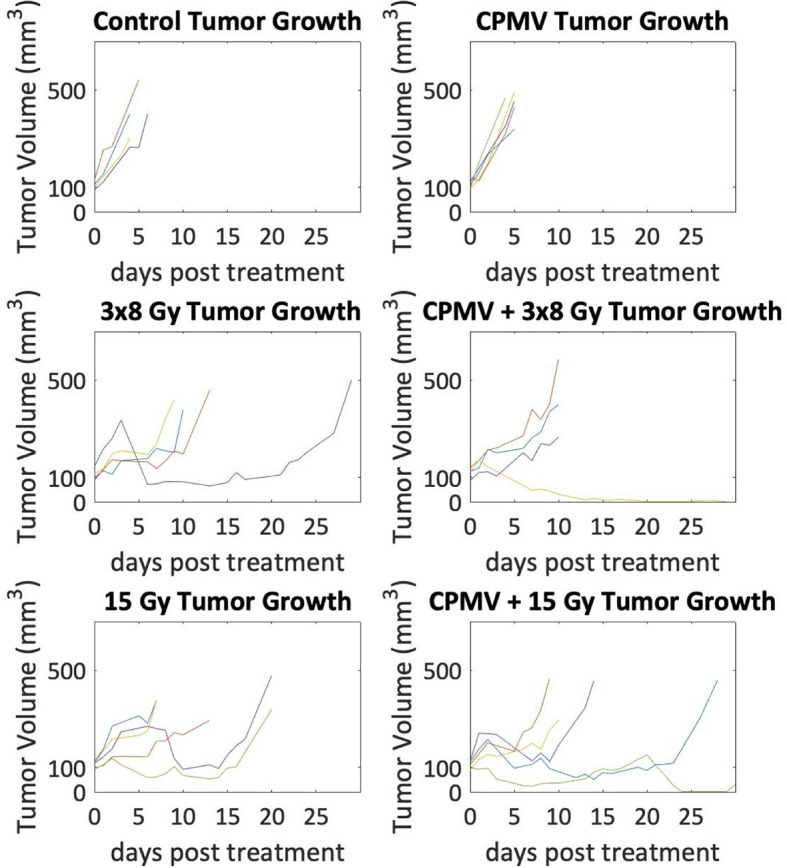
Tumor Growth Curves. Tumor growth curves for each animal with tumor volume on a logarithmic scale. Control and Cowpea mosaic virus (CPMV) tumor growth are exponential as the lines appear linear, whereas in the radiation cohorts there are several animals that do not follow exponential growth. Additionally, in the combinatorial CPMV and radiation cohorts there were a few animals whose tumor volumes decreased towards zero.